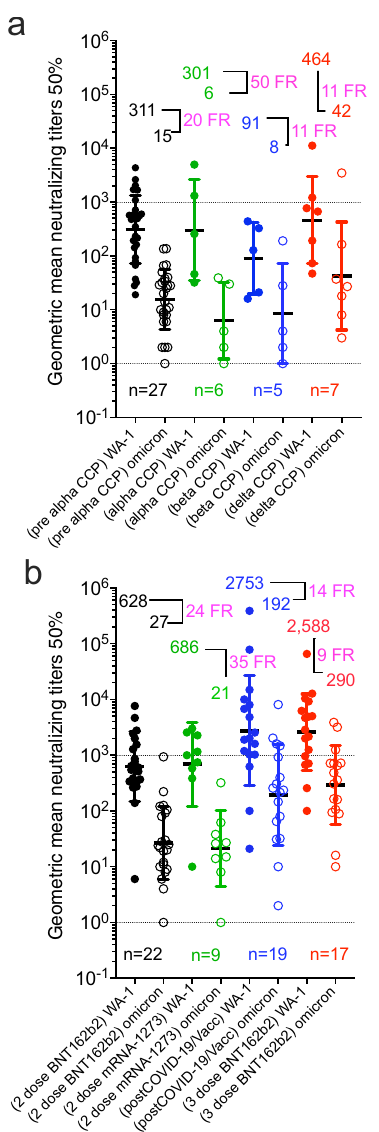
Fig. 2 | Geometric mean neutralizing titers (GMT 50 ) against WA-1 versus Omi- cronBA.1by study. a unvaccinated convalescentplasmaand b vaccinated plasma withorwithoutCOVID-19.Geomeansforentirestudygroupswithneutralizationof WA-1 in fi lled circles and of Omicron BA.1 in empty circles with geomeans (geo- metric standard deviation for error bars), fold reduction (FR) above data, and number of studies above x axis. All geomeans are not statistically signi fi cant in difference by multiple comparisons in Tukey ’ s test. Source data are provided as a Source Data fi